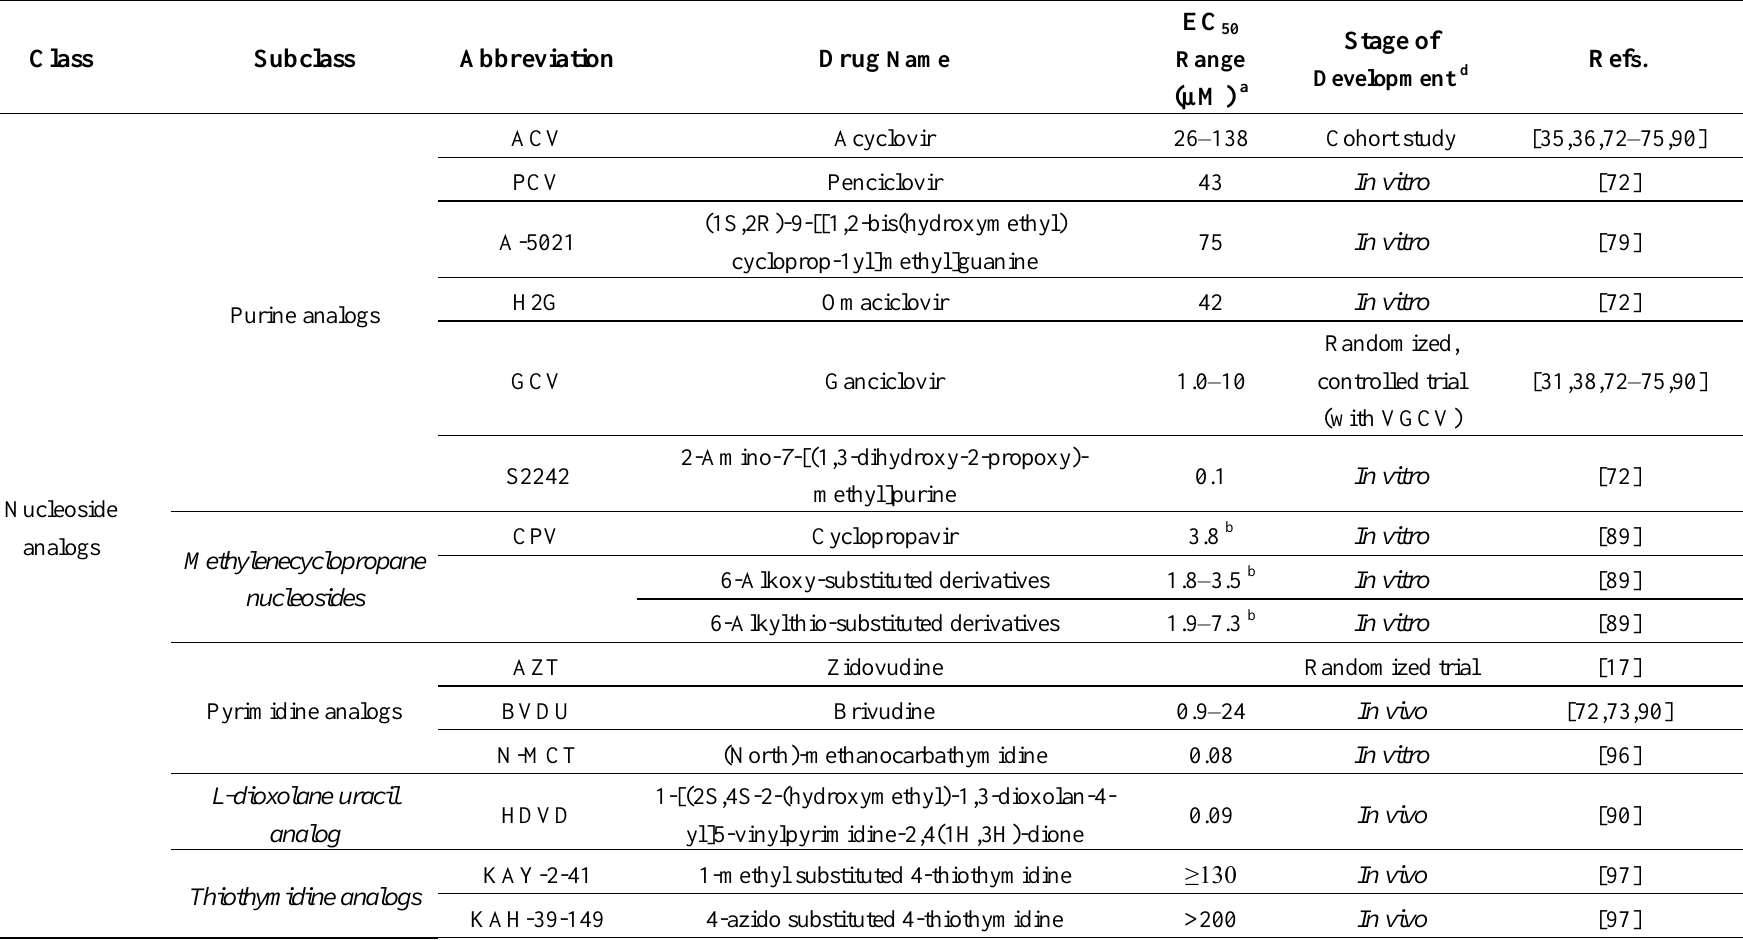
Table 2. Anti-KSHV activity of viral DNA polymerase